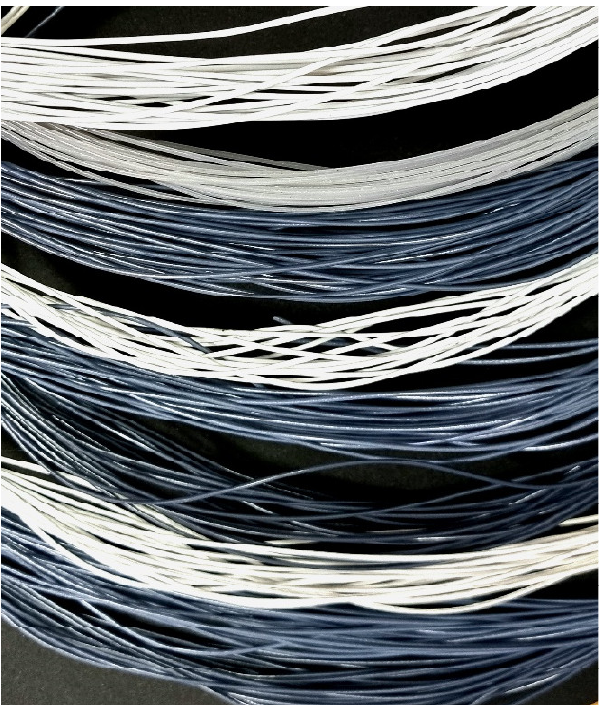
Figure 4. Extruded composite filaments for 3D printing with increasing filler content from top to bottom: PET-G 1.5T 0C, PET-G 1.5T 0.25C, PET-G 1.5T 0.5C, PET-G 3T 0C, PET-G 3T 0.25C, PET-G 3T 0.5C, PET-G 6T 0C, PET-G 6T 0.25C, and PET-G 6T